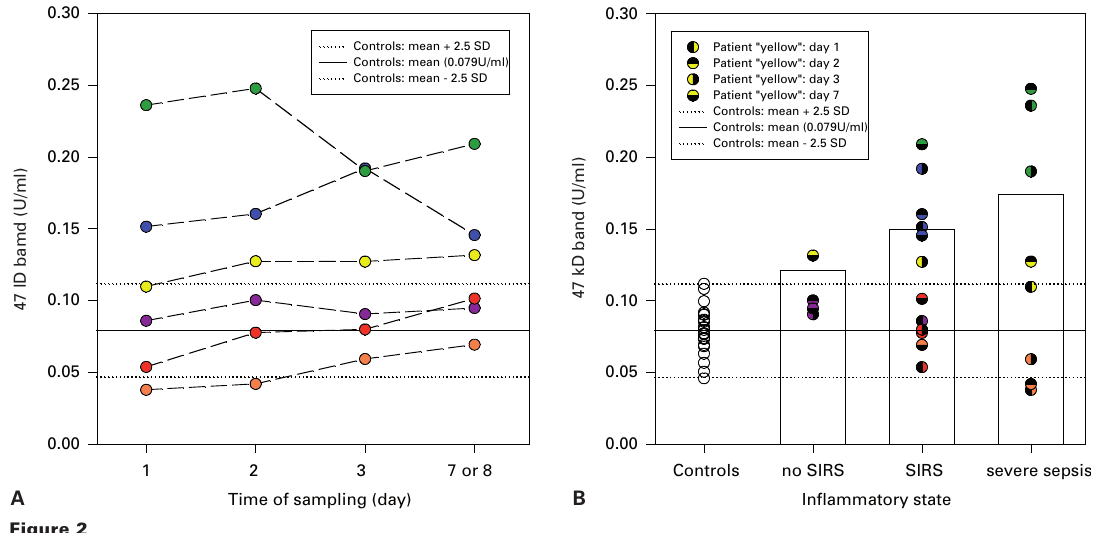
Contact system activation in sepsis vs. controls (analysis in U/ml). Panel A shows the six individual patients’ results over time. Panel B shows the analysis of 47kd light chain in U/ml as a func- tion of SiRS severity.The solid line depicts the mean of all normal controls; whereas the dotted line delimits the mean ± two standard deviations.The categories on the x-axis are normal controls (empty circles), patients without SiRS (all patients upon inclusion in the study had at least two SiRS criteria; on subsequent days of testing some patients only presented 1 or 0 SiRS defining criteria and therefore were categorised in the “no SiRS” group), patients with sepsis and patients with severe sepsis (including septic shock).The insert correlates the symbols with the respective patients and time of blood draw.The empty bars indicate the mean CSA for each category.